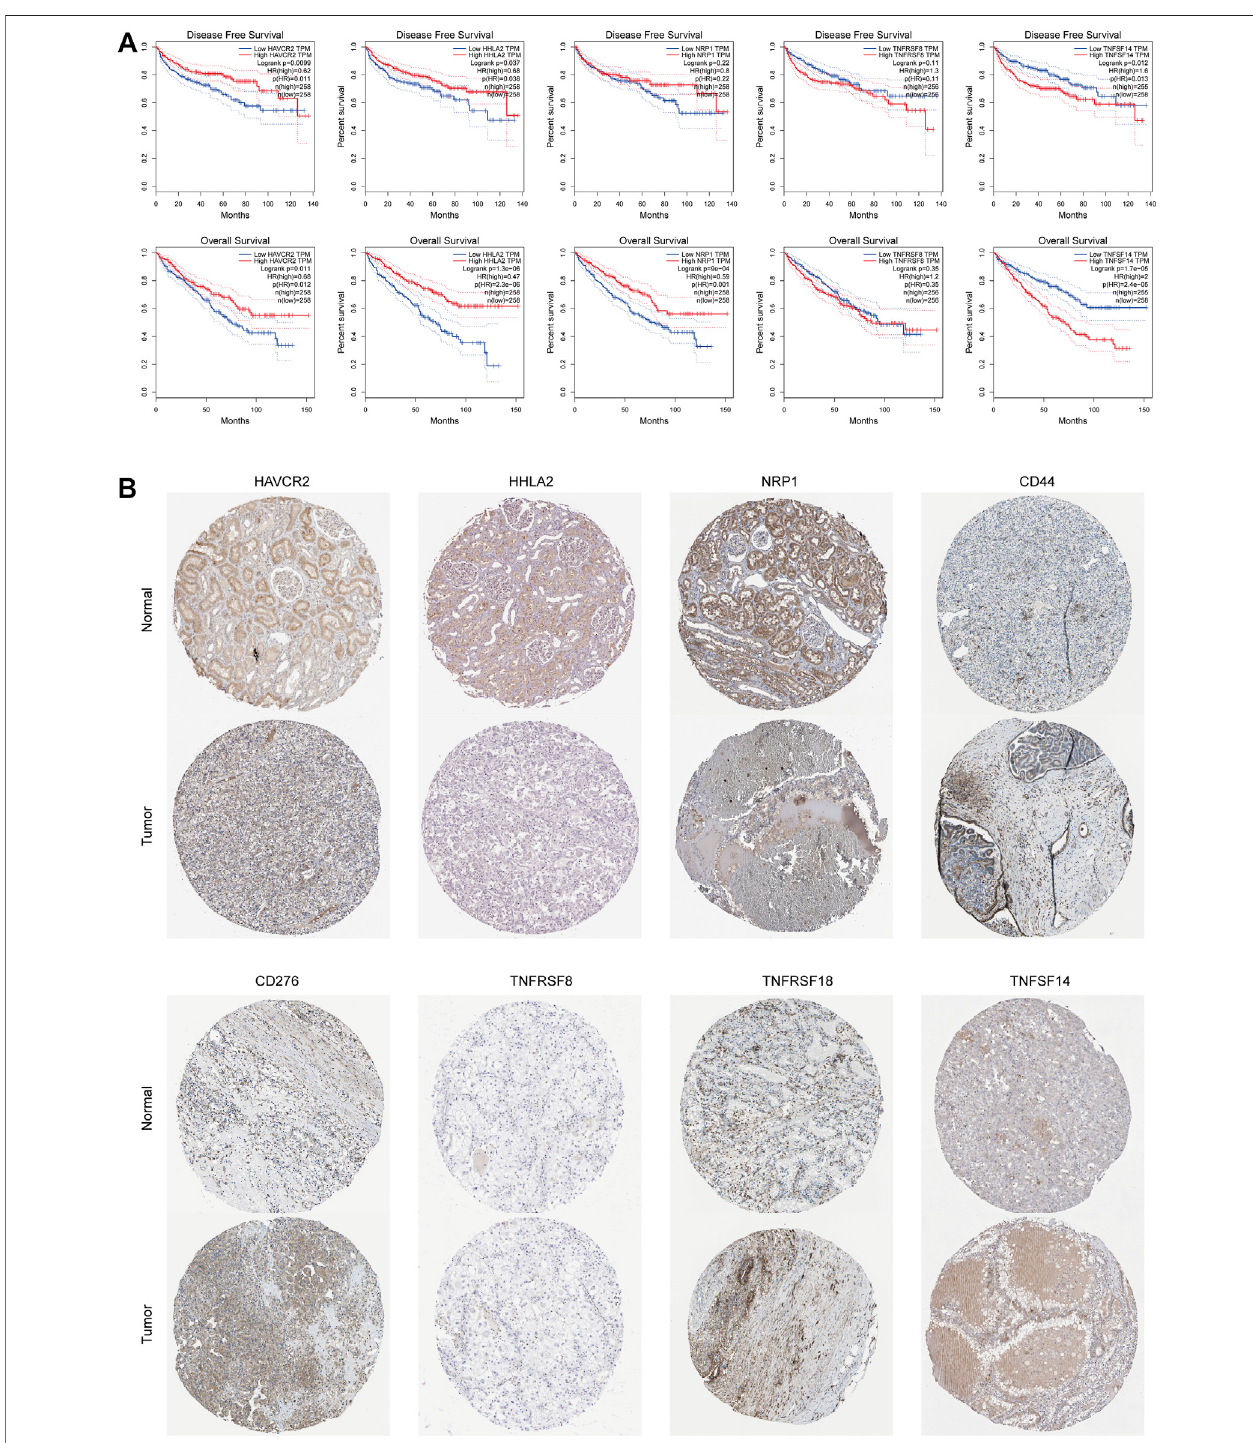
FIGURE 6 | Immunological checkpoint variability. (A) Expression levels of TNFSF14, TNFRSF18, NRP1, HAVCR2, and HHLA2 were signi fi cantly associated with prognosis in ccRCC patients and were statistically signi fi cant on both OS and DFS. (B) Verify the translational expression of the immune checkpoints genes in ccRCC and normal kidney